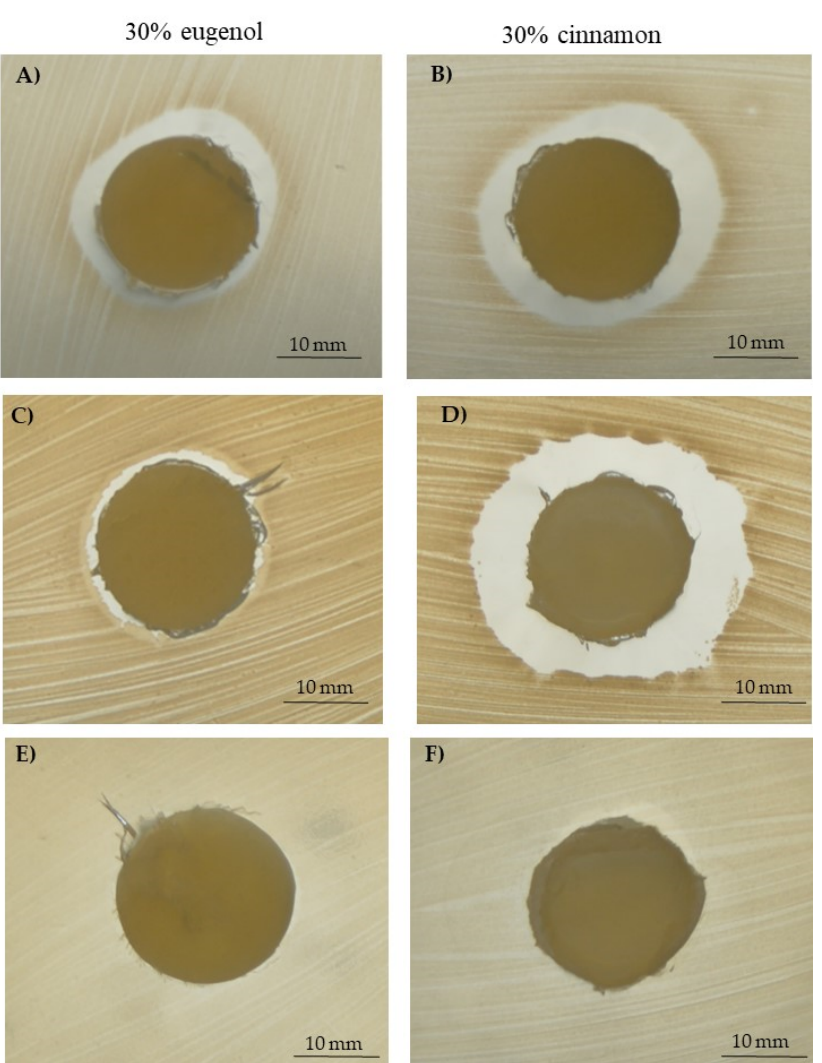
Figure 9. Representative images of the inhibition halo test: PCL-based samples enriched with 30% eugenol or 30% cinnamon oil towards S. aureus ( A , B ), S. epidermidis ( C , D ) and E. coli ( E , F ).